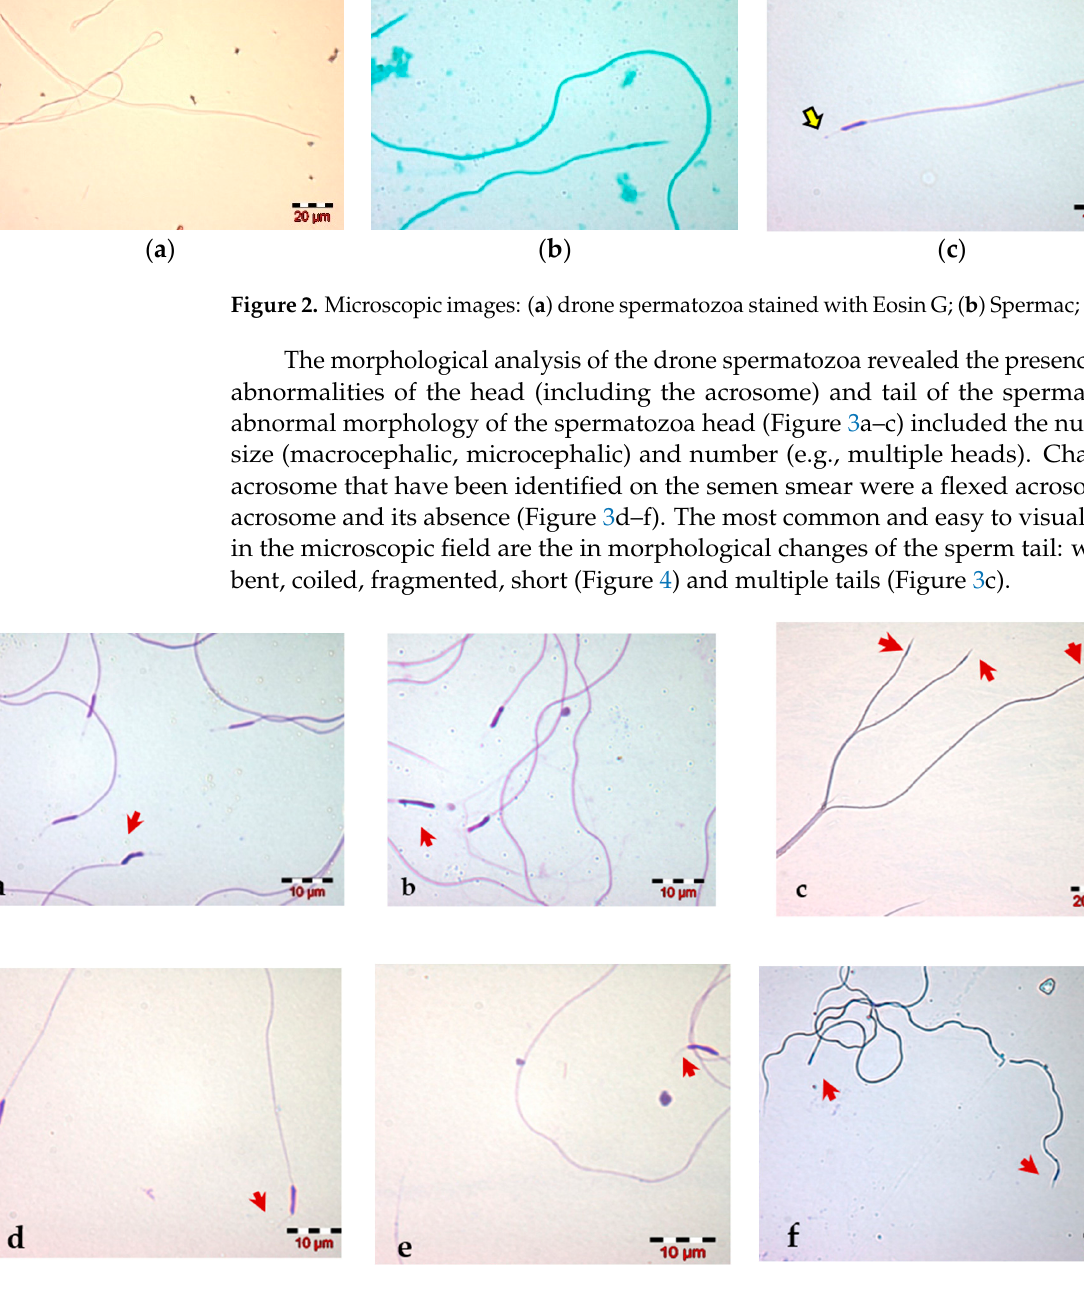
Figure 3. Microscopic images: abnormal morphology of ( a – c ) honey bee drone sperm head and ( d – f ) acrosome.